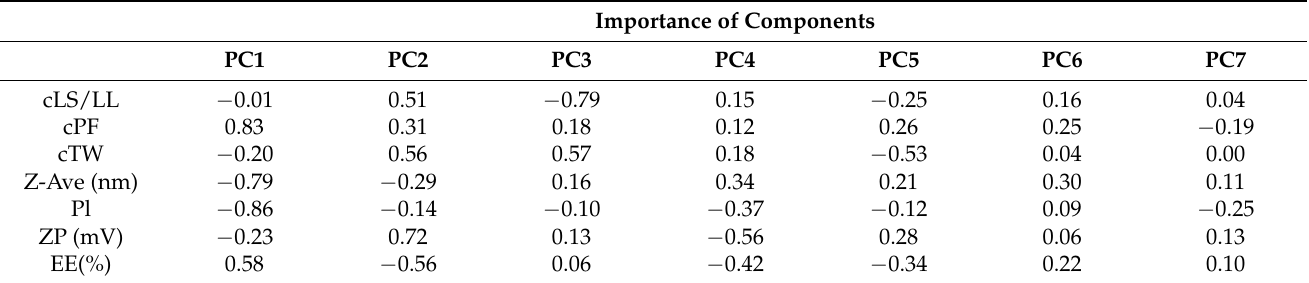
Table 6. Correlation matrix of variables and principal components.